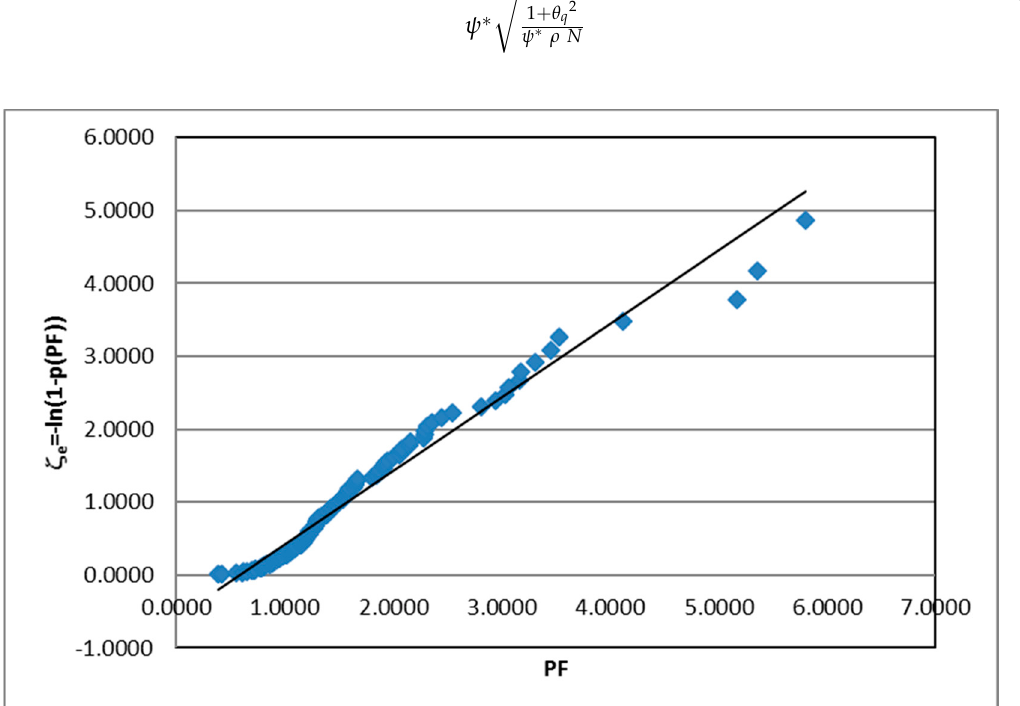
Figure 9. The exponential probability plot of the Peak Factor distribution (diamonds points) and the linear regression (black line).